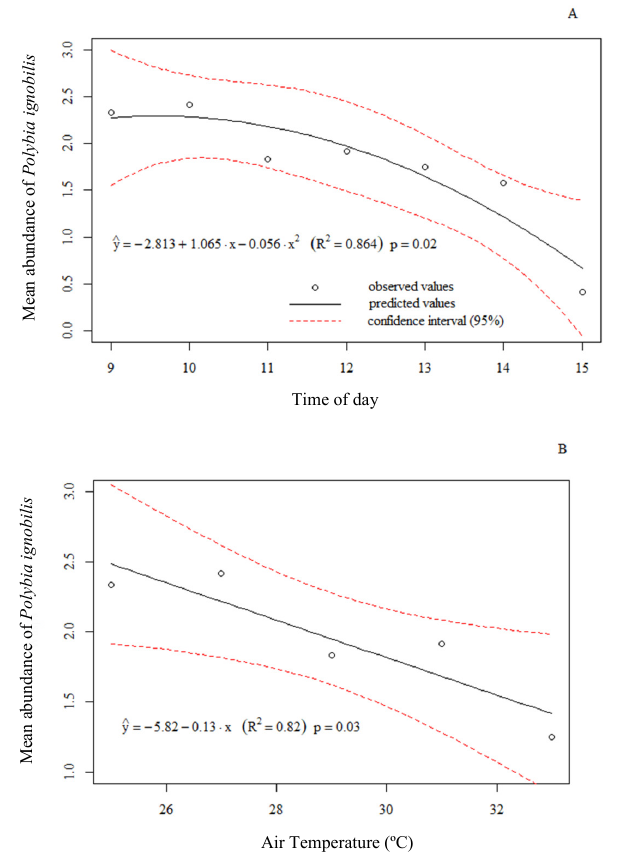
Fig 3 . Average number of wasps of Polybia ignobilis (Hymenoptera: Vespidae) foraging in kale plants ( Brassica oleracea var. acephala ) as a function of: A -timeof day and; B - air temperature, from July to November 2016 in Bambuí,